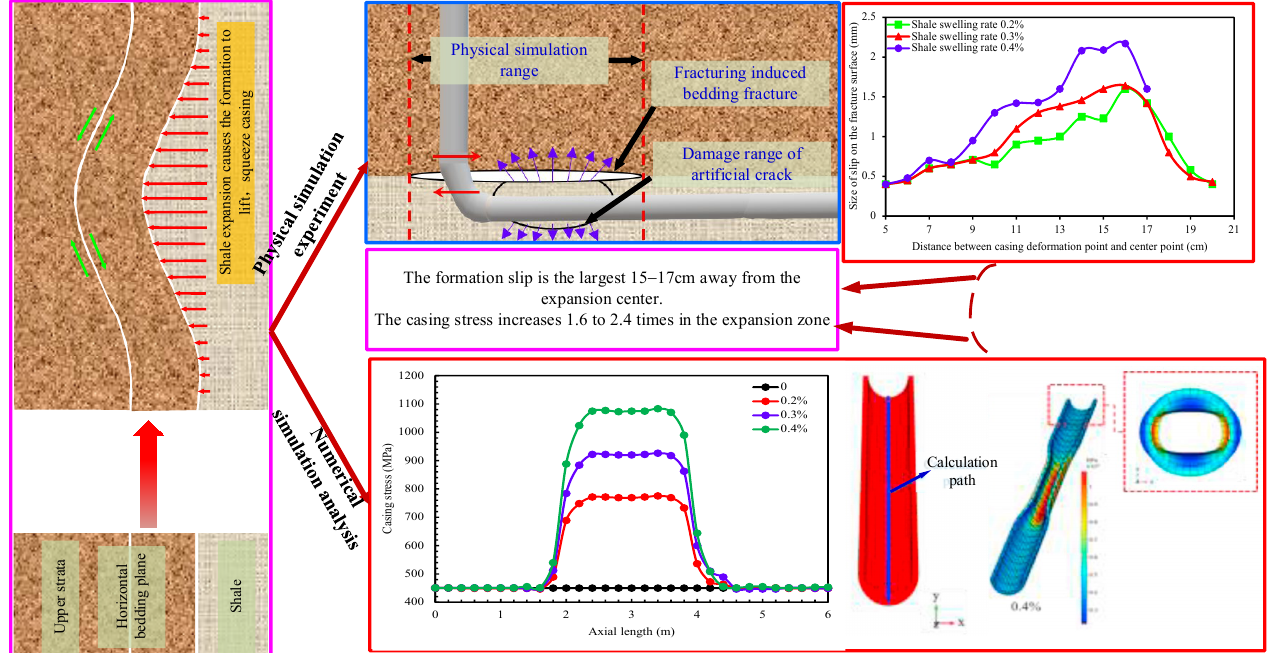
Figure 5. Effects of shale swelling on fractures and casing (numerical simulation from Li [41]).